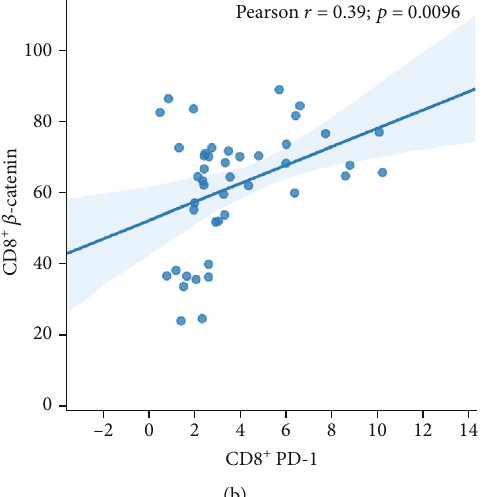
Figure 7: (a) The correlation of β -catenin, PD-1, and IFN- γ on CD8 T cells. (b) The correlation of β -catenin and PD-1 on CD8 T cells ( n = 47 ).